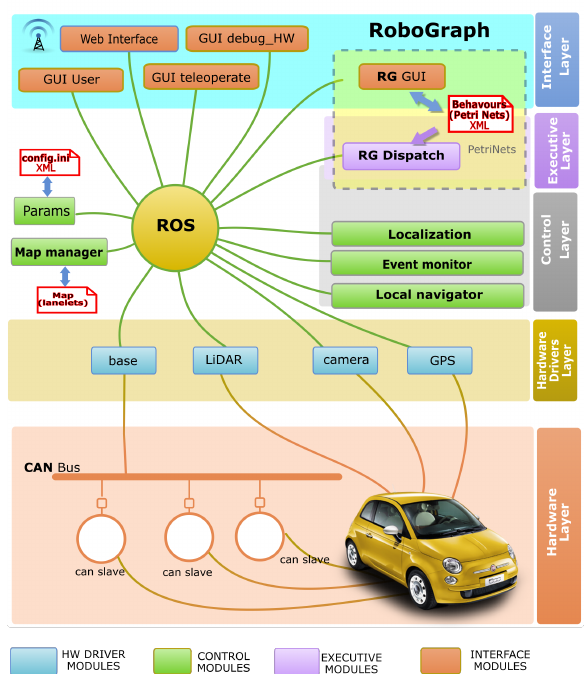
Figure 1. Car software architecture. ROS = Robot Operating System; GUI = graphical user interface; HW = Hardware; RG = RoboGraph; GPS = Global Positioning System; LIDAR = Light Detection and